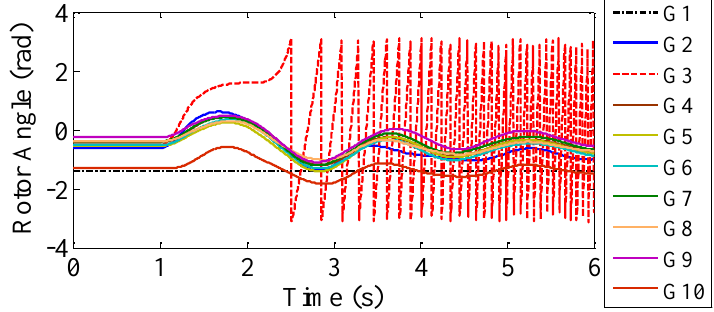
Figure 15. Rotor angles of synchronous generators with the 236 ms fault on line 10–13.